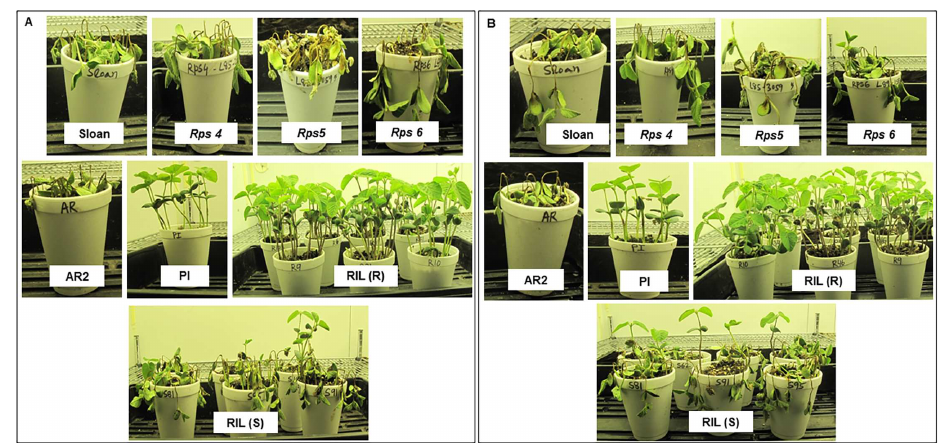
Fig 1. Reactions of soybean differentials carrying Rps4 , Rps5 , and Rps6 genes and RILs with or without the novel Rps gene to (A) a mixture of P . sojae of R17 and Val12-11isolates, and (B) the P . sojae P7074 isolate. The presence of a dying or expandedlesionindicatesa susceptibleresponseor compatibleinteraction. Resistance responseis expressedas hypersensitive cell death at the inoculationsites and healthynature of infected plants. AR2, susceptible parent AR2; PI, resistant parent PI399036containing the novel Rps gene; RIL (R), randomly selectedrecombinant inbredlines resistant to P . sojae isolates; RIL (S), randomlyselectedrecombinantinbred lines susceptibleto P . sojae isolates; Sloan, the susceptible cultivar Sloan with no known Rps genes used as the susceptible